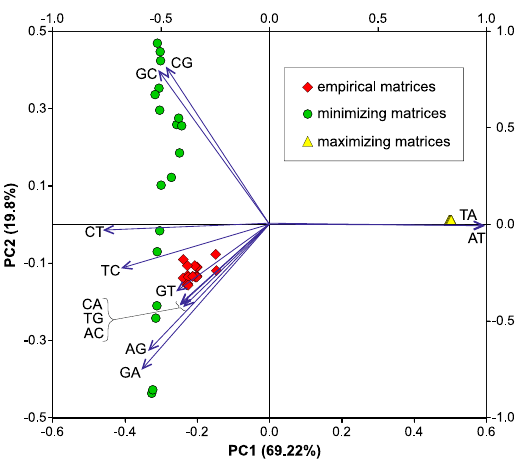
Figure 7. Biplot for results of Principal Component Analysis based on probability rates of the empirical matrices and matrices from Pareto fronts, which minimized or maximized both physicochemical costs of amino acid replacements A covariance matrix was assumed in the calculation of the principal